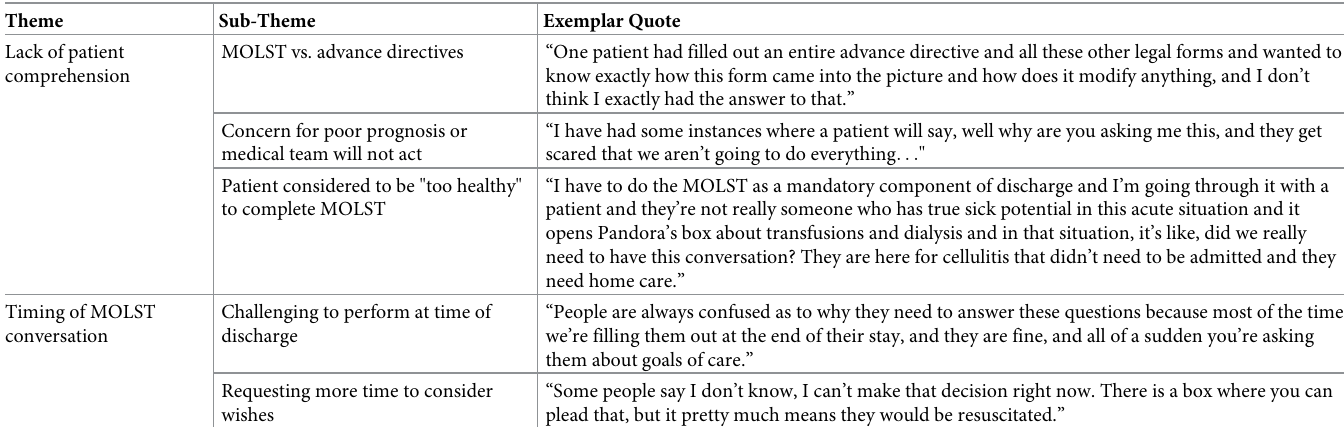
Table 3. Perceived patient barriers leading to lack of physician comfort.